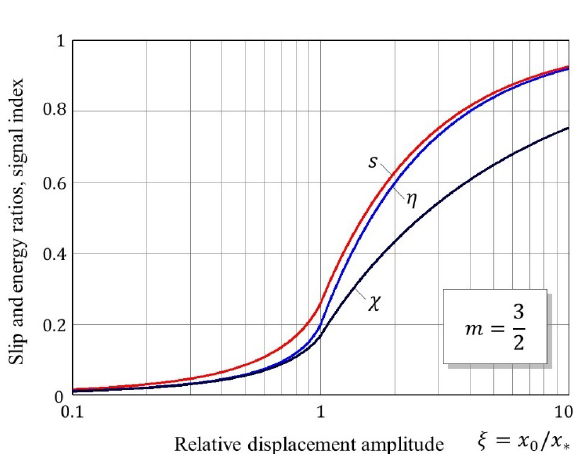
Fig. 4 Transition criteria.